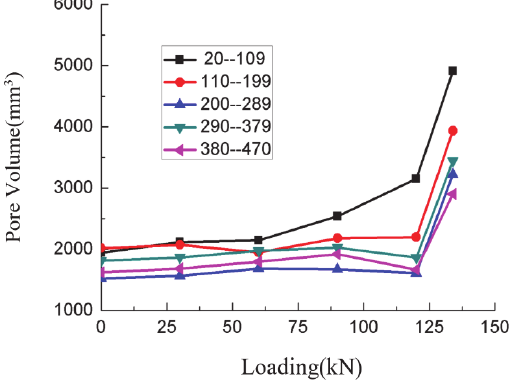
Figure 7: Pore volume-pressure map.